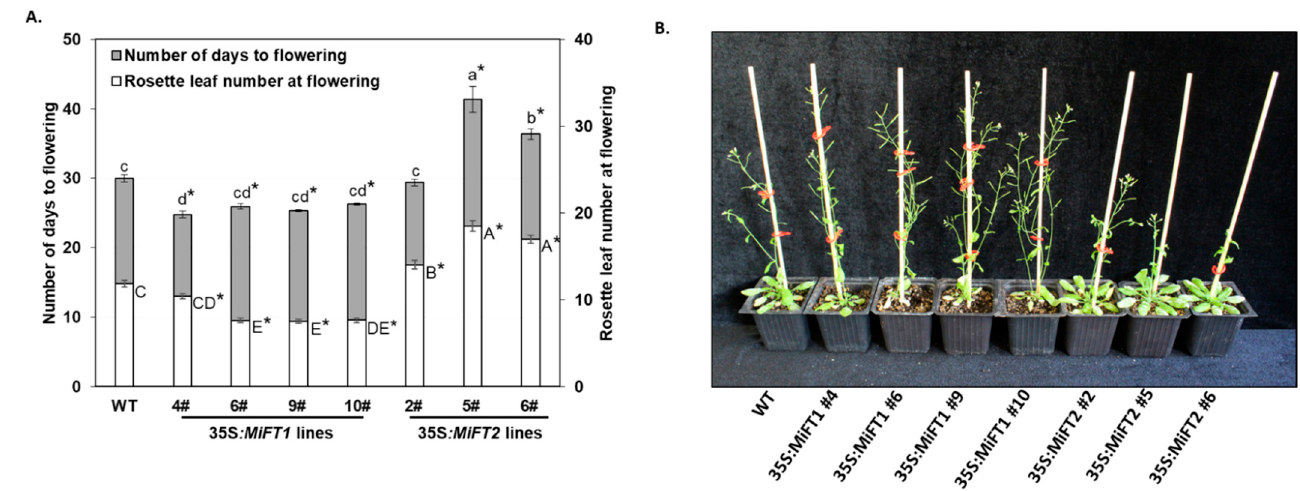
Figure 3. Ectopic expression of ‘Shelly’ MiFT1 and MiFT2 genes in Arabidopsis . ( A ) Number of days to flowering and rosette leaf’s at bolting of Arabidopsis Col-0 (WT), four representative lines constitutively expressing MiFT1, and three representative lines constitutively expressing MiFT2, under LD conditions. Values represent means ± SE of number of days to flowering and number of rosette leaves at flowering; n = 7–34 plants per line. Different small or capital letters indicate significant differences of number of days to flowering or rosette leaf number at bolting, using Tukey– Kramer multiple comparison test, with p ≤ 0.05. Asterisks (*) denote a significant difference between the control and a specific 35S: MiFT1- or MiFT2 -overexpressing line, using least significant difference (LSD) test, according to pairwise comparison by Student’s t -test, with p ≤ 0.05. ( B ) MiFT1- and MiFT2 -overexpressing lines exhibiting early and late flowering phenotypes, respectively, relative to WT plants under LD conditions. Photographs were taken 32 days after